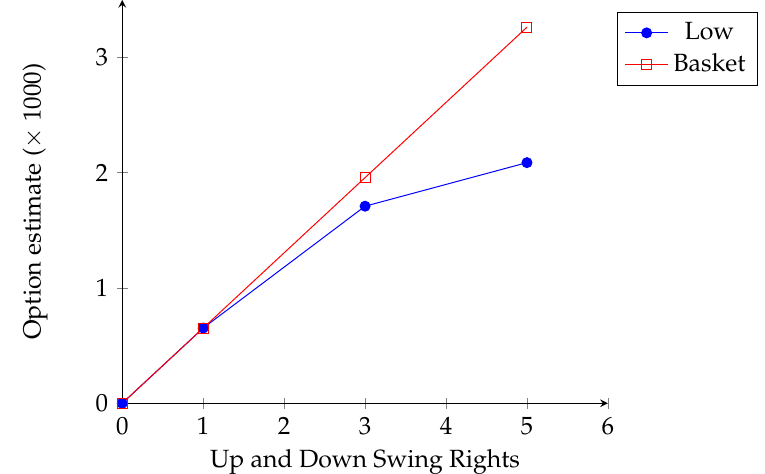
Figure 6. Basket of American calls and puts and swing option values versus the number of exercise rights using a 5-dimensional underlying asset. Parameter values used are exercise volume of 60 units, S 0 = 40, b = 20, R = 4000, m = 5, and no usage